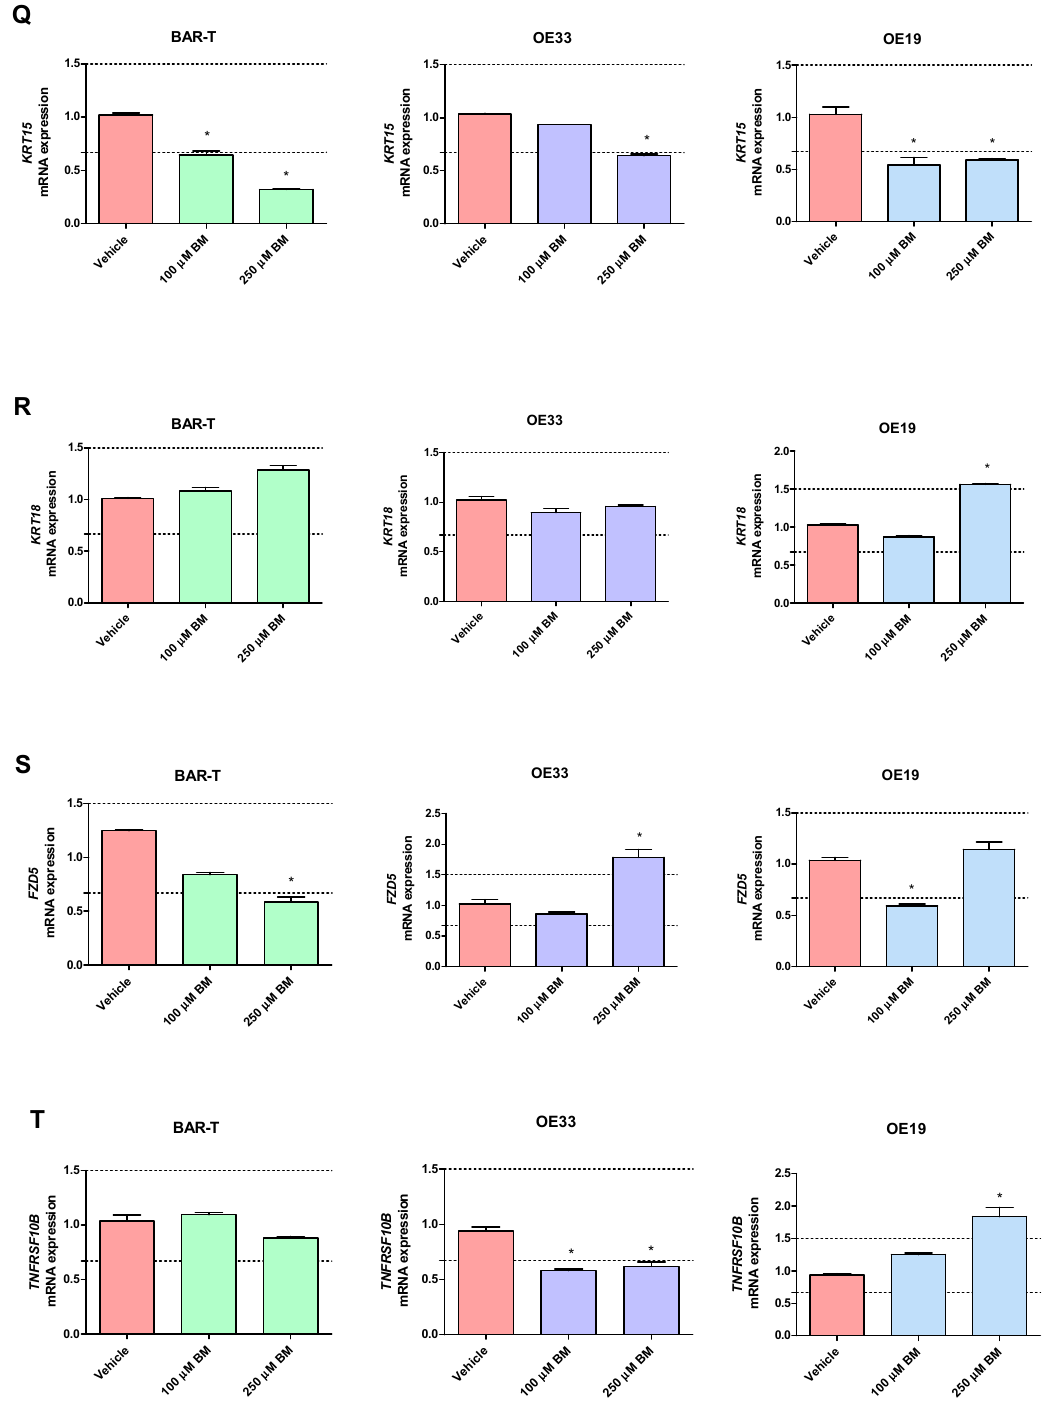
Figure 6. Alterations in PTGS1 ( A ), PTGS2 ( B ), IL1A ( C ), IL1B ( D ), IL1R1 ( E ), IL1RN ( F ), TIMP1 ( G ), TMEM2 ( H ), IFNGR1 ( I ), NFKBIL1 ( J ), SOCS3 ( K ), SOX4 ( L ), SOX9 ( M ), SOX15 ( N ), KRT4 ( O ), KRT8 ( P ), KRT15 ( Q ), KRT18 ( R ), FZD5 ( S ), TNFRSF10B ( T ) mRNA expression profiles for BAR-T, OE33 and OE19 cells treated for 6 days with acidified bile mixture (BM) to reflect clinical gastroesophageal reflux disease (GERD). Cell lines were exposed daily to 100 or 250 μ M of BM applied in acidified medium. Vehicle indicates the cells cultured in regular medium without BM. Dotted lines indicate 1.5-fold up-/downregulation of mRNA expression compared to vehicle. Results are shown as the mean ± SEM of 3 values per experimental group. Statistically significant changes compared with a vehicle were marked with an asterisk (*) ( p <